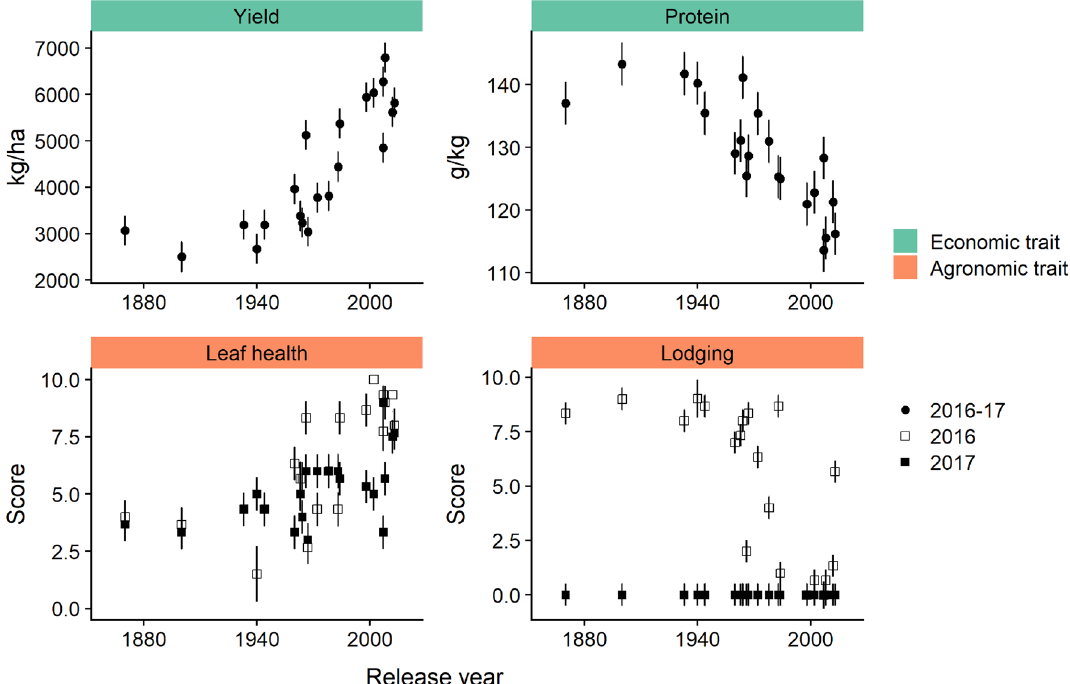
are shown for 2016 and 2017 separately; leaf health and lodging were scored on a scale of 0–10 where 0 = no green on flag leaf and 10 = flag leaf completely green for leaf health and 0 = no lodging and 10 = completely flat